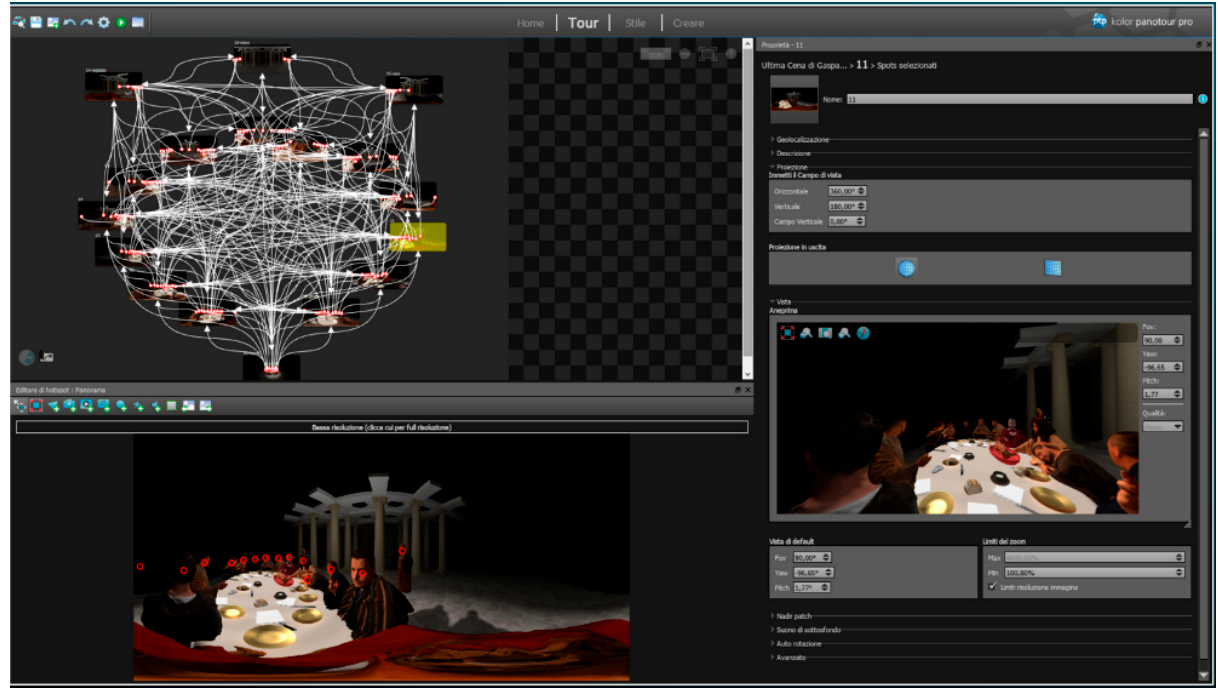
Figure 21. Creation of the Virtual Tour.